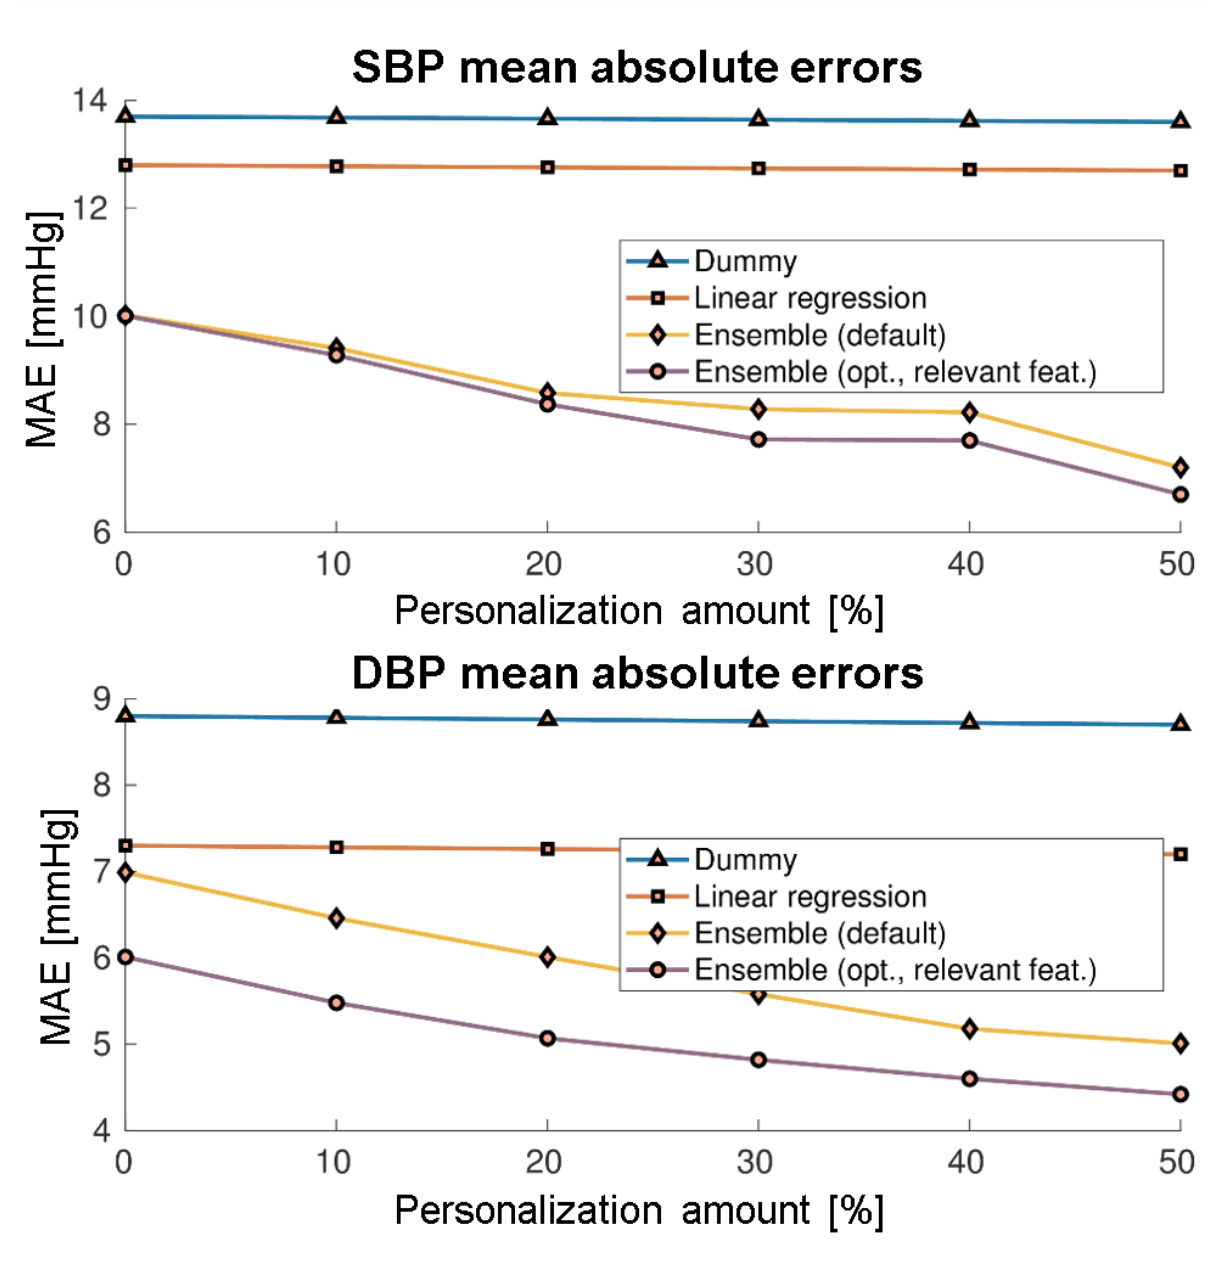
Figure 7. Mean absolute error of systolic blood pressure and diastolic blood pressure estimation in the leave-one-subject-out experiment using